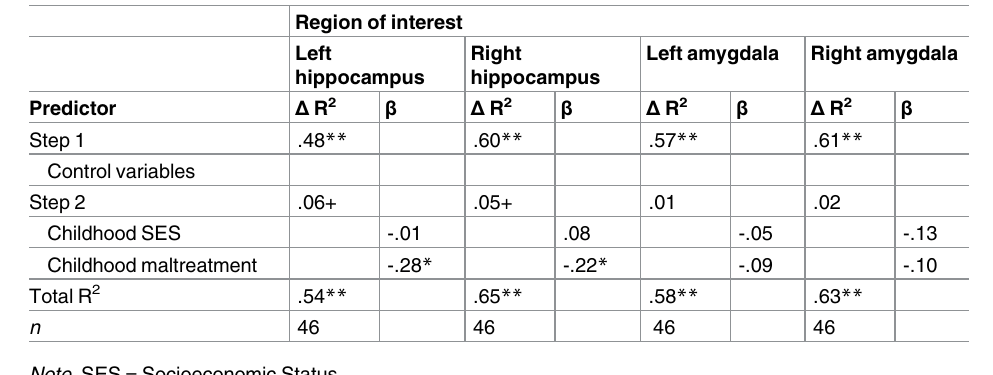
Table 3. Results from hierarchical multiple linear regression using control variables (age, sex, BMI, total brain volume), followed by childhood SES and childhood maltreatment to predict volume of the hippocampus and